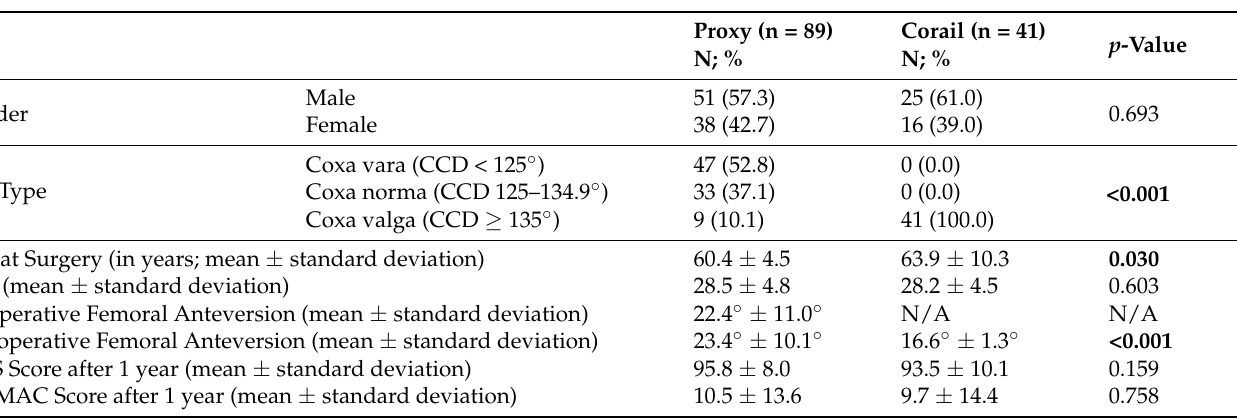
Table 1. Demographic and clinical